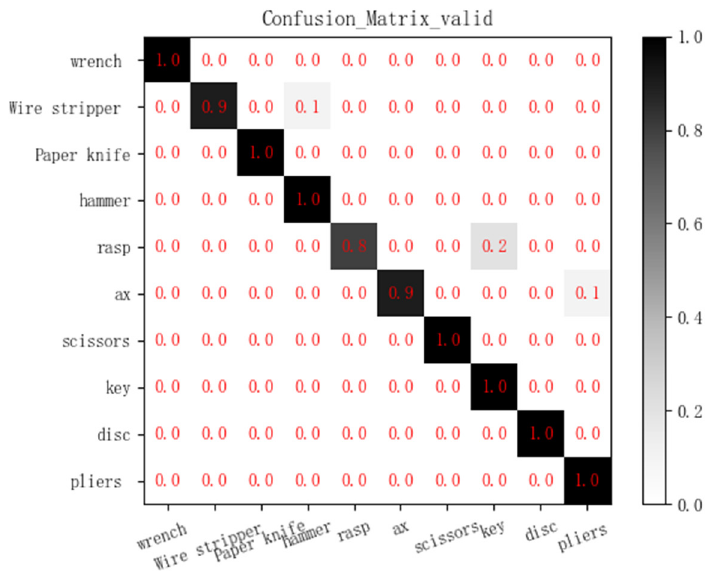
Figure 13. GhostNet_ResNet56 confusion matrix on the SAR validation set.